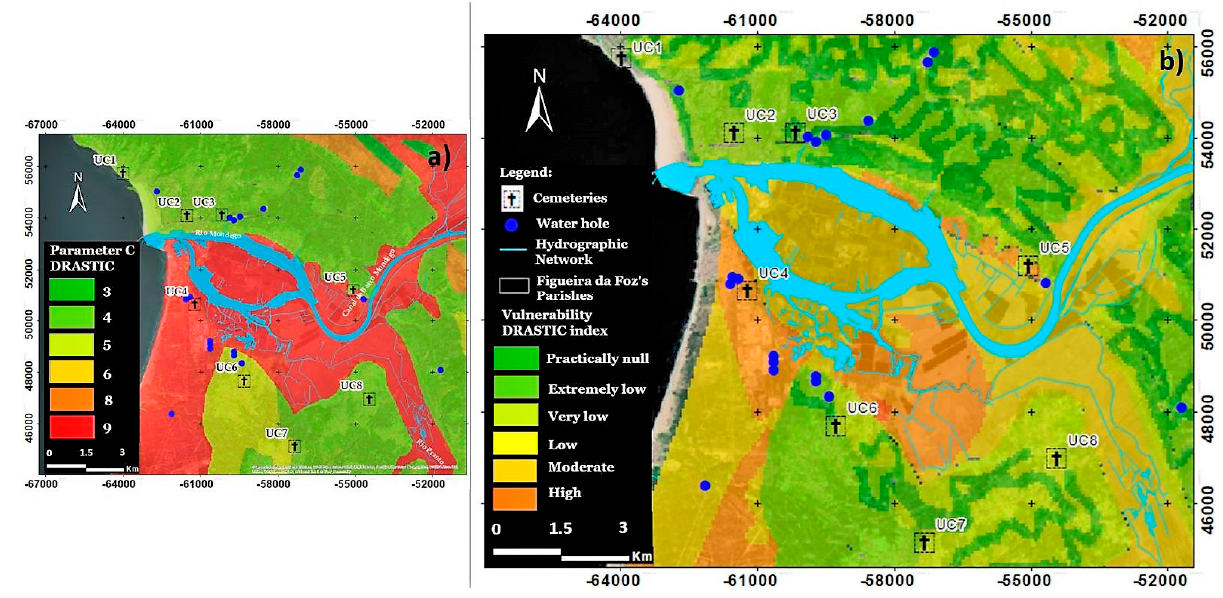
Figure 10. a ) Parameter C map; b ) vulnerability map to pollution of the studied area. Figure 10. ( a ) Parameter C map; ( b ) vulnerability map to pollution of the studied area. Table 4. Ratings, index values, and qualitative classification for the eight cemeteries. DRASTIC